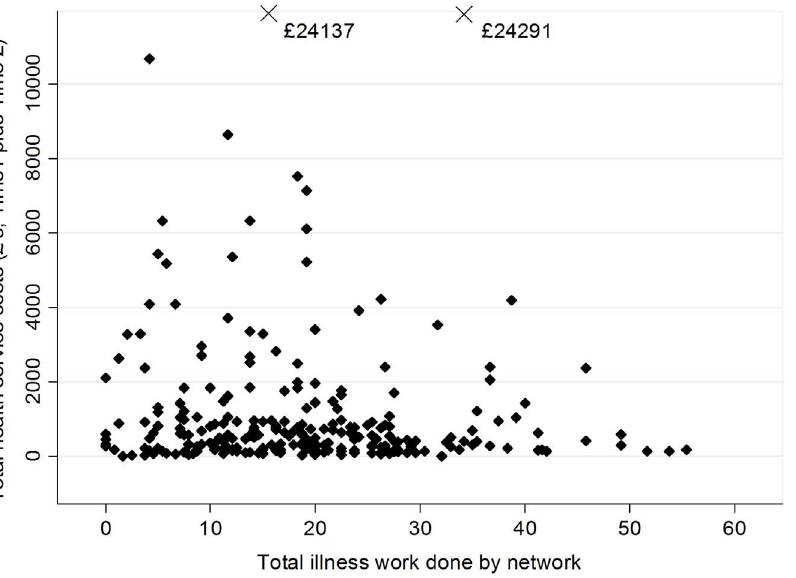
Figure 3. Total service costs (Time 1 plus Time 2) by amount of illness work done by the network. X = outlier value. doi:10.1371/journal.pone.0098340.g003 PLOS ONE |